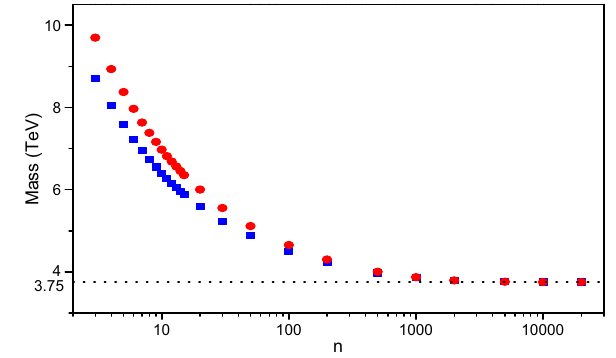
Fig. 6 The regularized monopole energy in terms of n in log scale. The red dots represent the energy given by (36) with A = B = 0. For comparison we plot the monopole energy given by (22) in blue dots. Here the dotted line represents the asymptotic energy when n goes to infinity